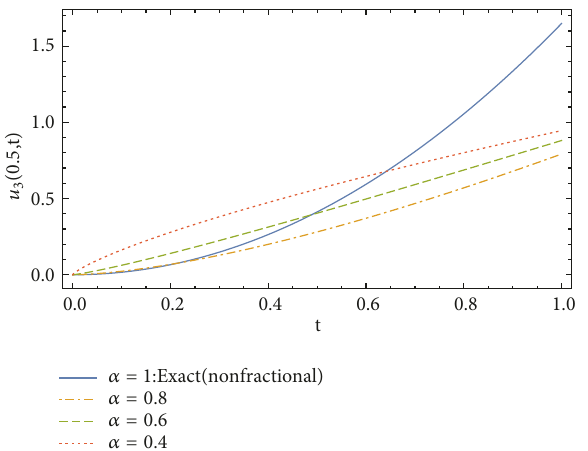
Figure 2: The 3-term FRDTM solutions 𝑢 3 for 𝛼 = 1 ( exact ),0.8, 0.6,0.4 ; 𝑡 ∈ [0,1] ; and 𝑥 = 0.5 .